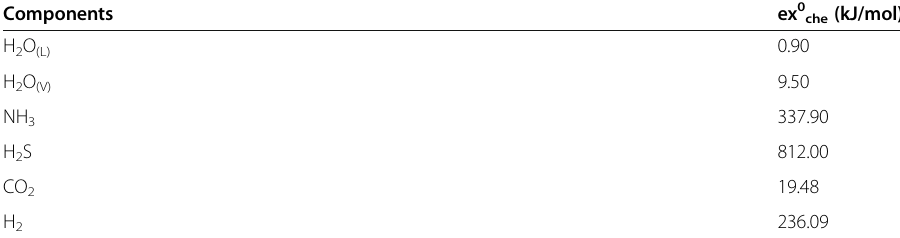
Table 10 Standard chemical exergy values for the components used in the study Components